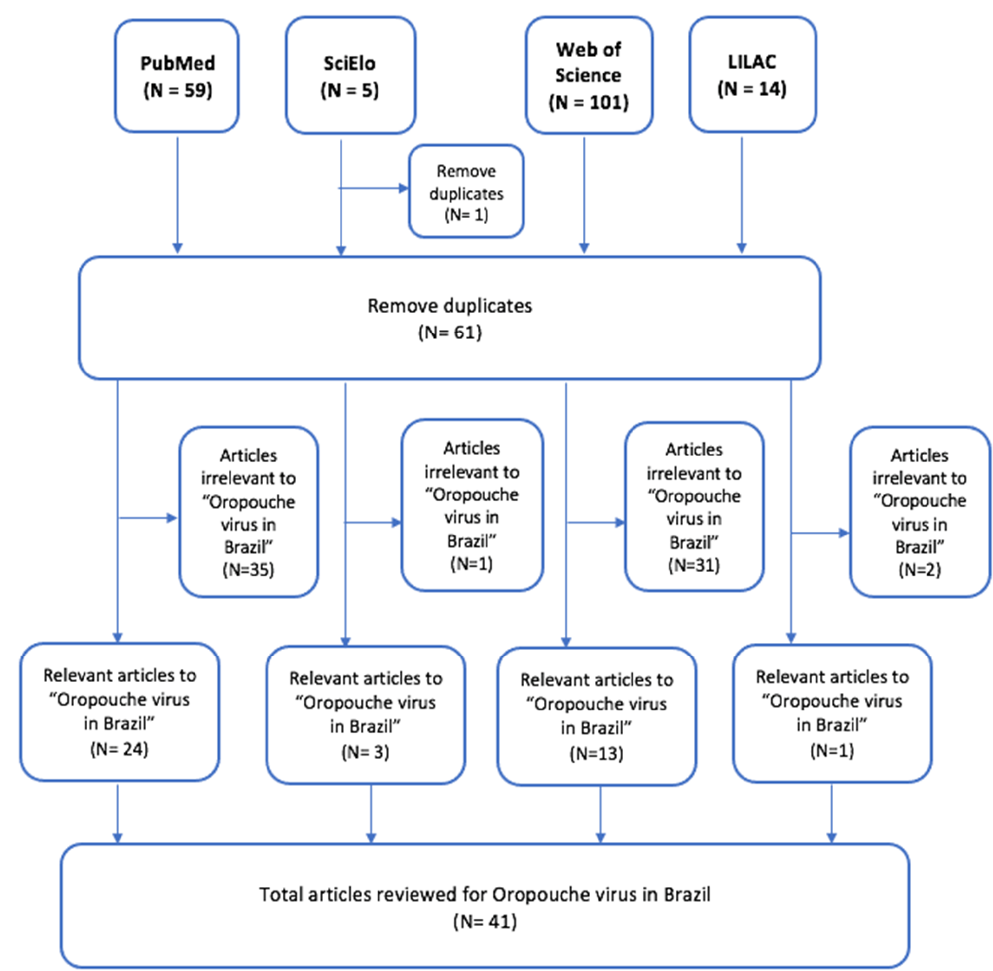
Figure 1. Flow chart of search results for scoping review.